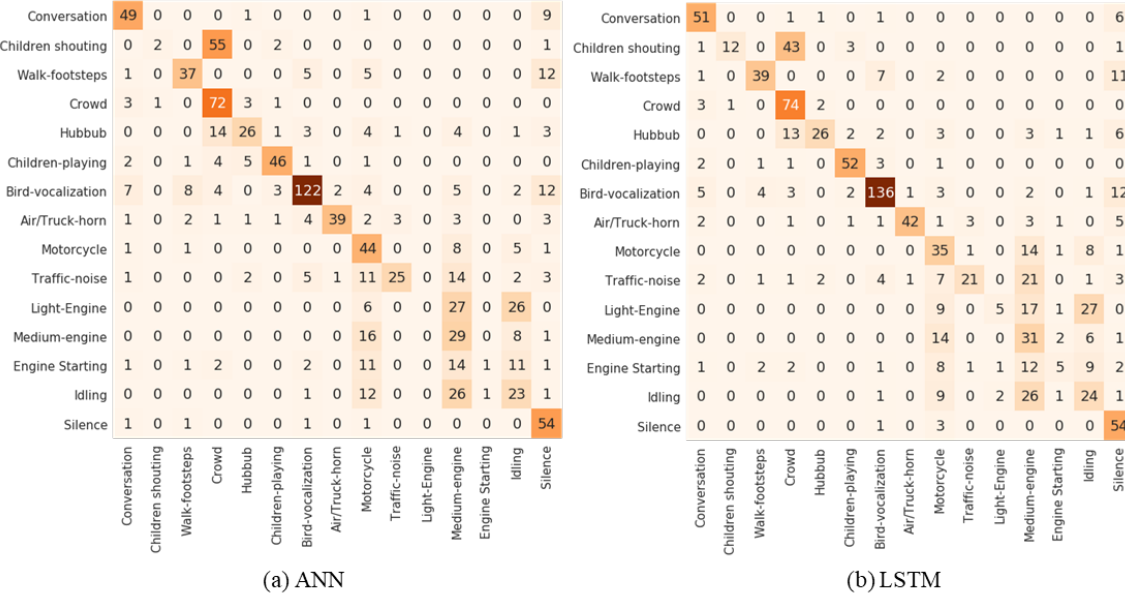
Figure 2: Confusion matrix showing the classification results of (a) ANN and (b) LSTM models